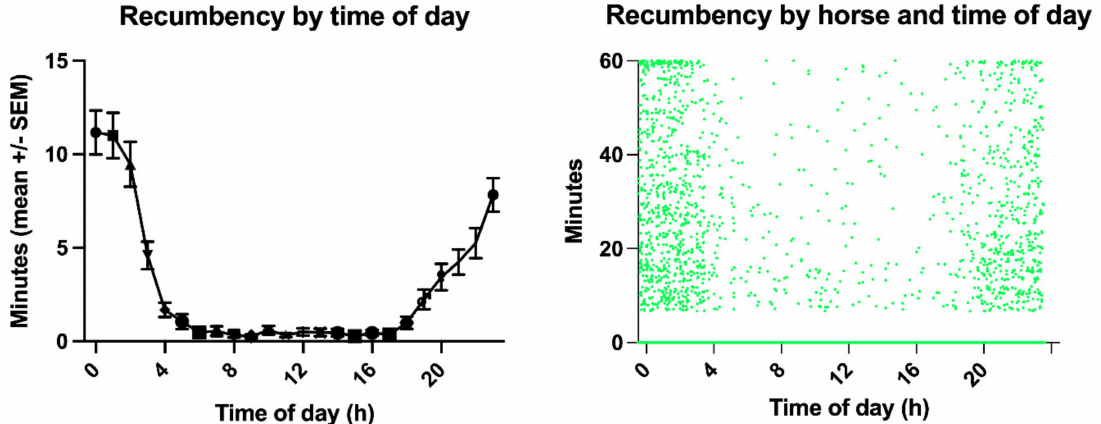
Figure 3. The left graph illustrates the recumbency times throughout the day, showing the primarily nocturnal recumbency distribution with a peak between midnight and 4:00 a.m. The right graph, the scatter plot of the recumbency minutes per horse, demonstrates the individual variation of the circadian sleep rhythm of the horses enrolled in this study. Twenty-nine horses were recumbent for less than 30 min per day throughout the entire study period, 13 of which all suffered from chronic orthopedic disease and did not lie down at all for more than 72 h (Figure 4); five of these horses lay down during subsequent tracking periods for 2–48 min. Thirty horses were consistently recumbent for more than one hour per day (Figure